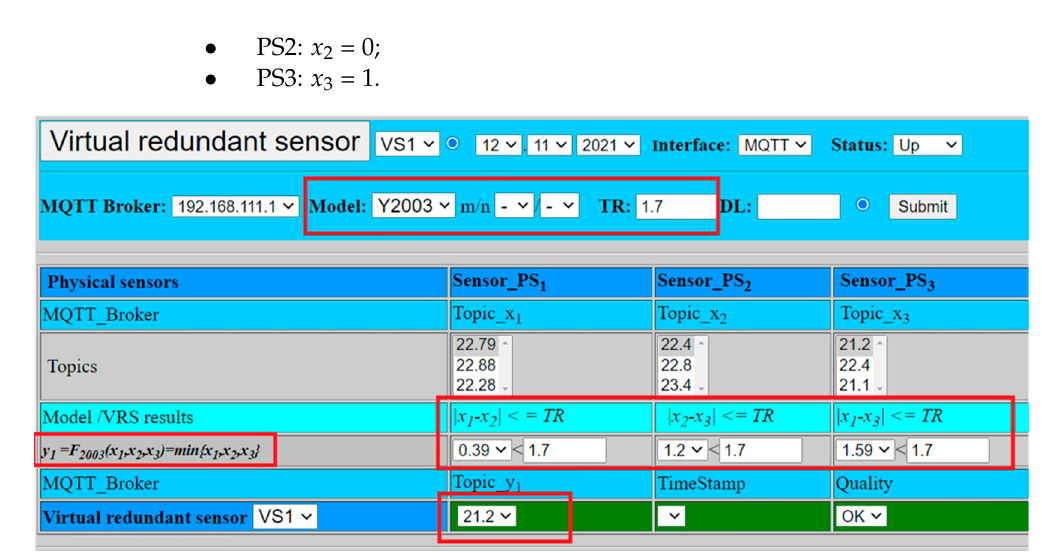
Figure 14. Virtual redundant sensor with fusion function F 2oo3 and positive result.